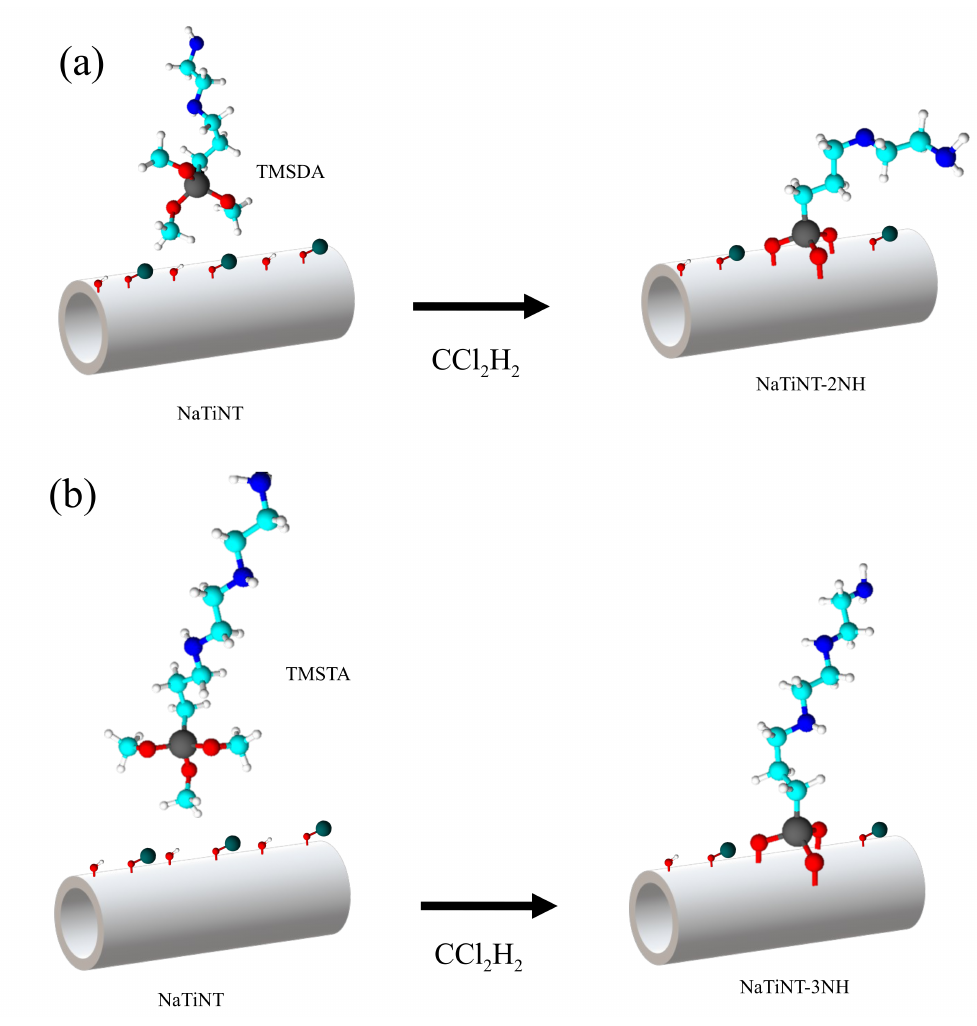
Figure 5. Proposed reaction scheme for the synthesis of ( a ) NaTiNT − 2NH and ( b ) NaTiNT − 3NH from